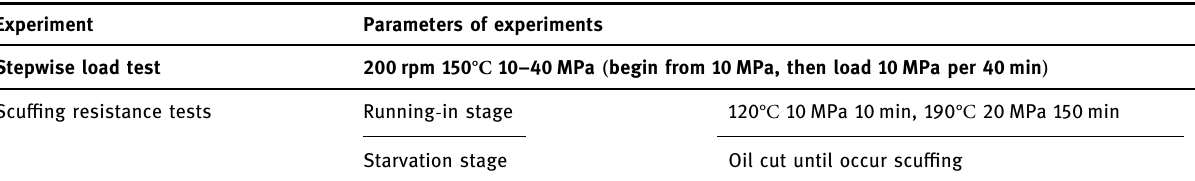
Table 1: Experimental conditions of the stepwise load tests and scu ffi ng resistance tests Experiment Parameters of